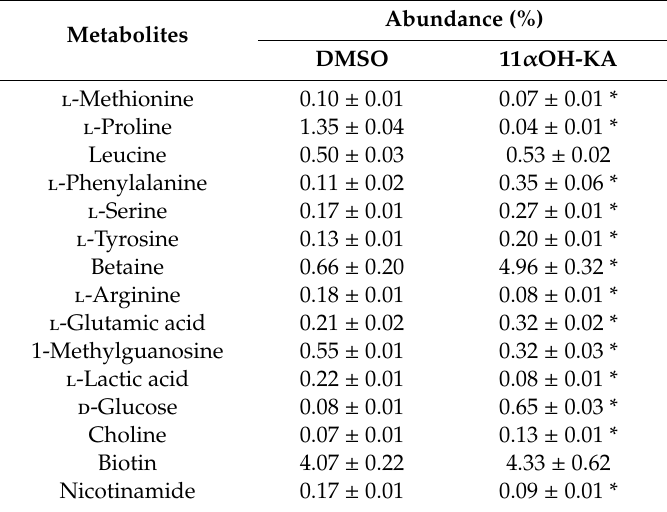
Table 2. Analyses intracellular yeast metabolites following 11 α OH-KA (45 µ g mL − 1 ) treatment, as analyzed by the LC / MS approach.